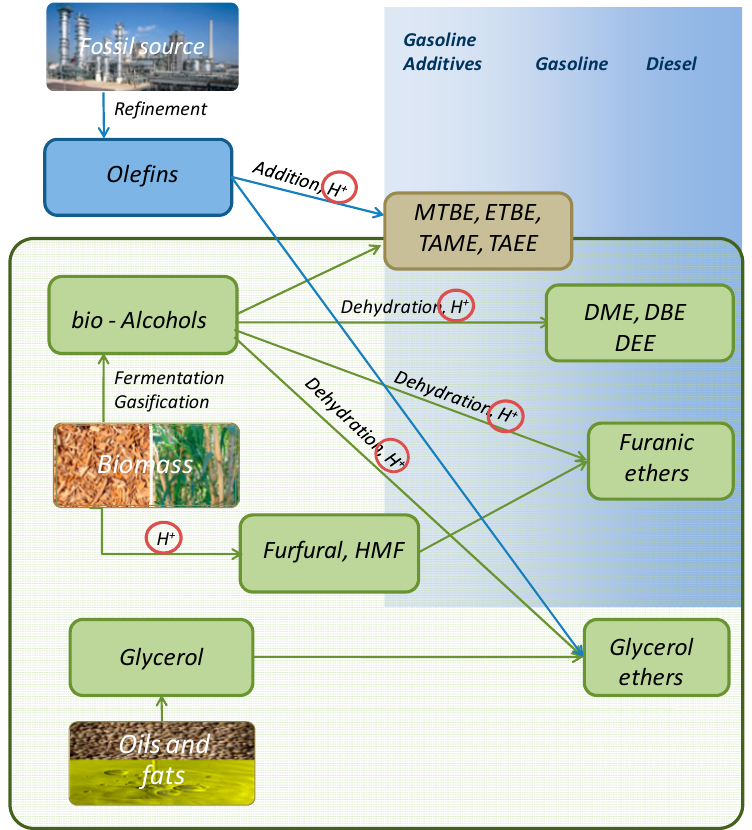
Figure 1. Major routes to ethers for fuel blending